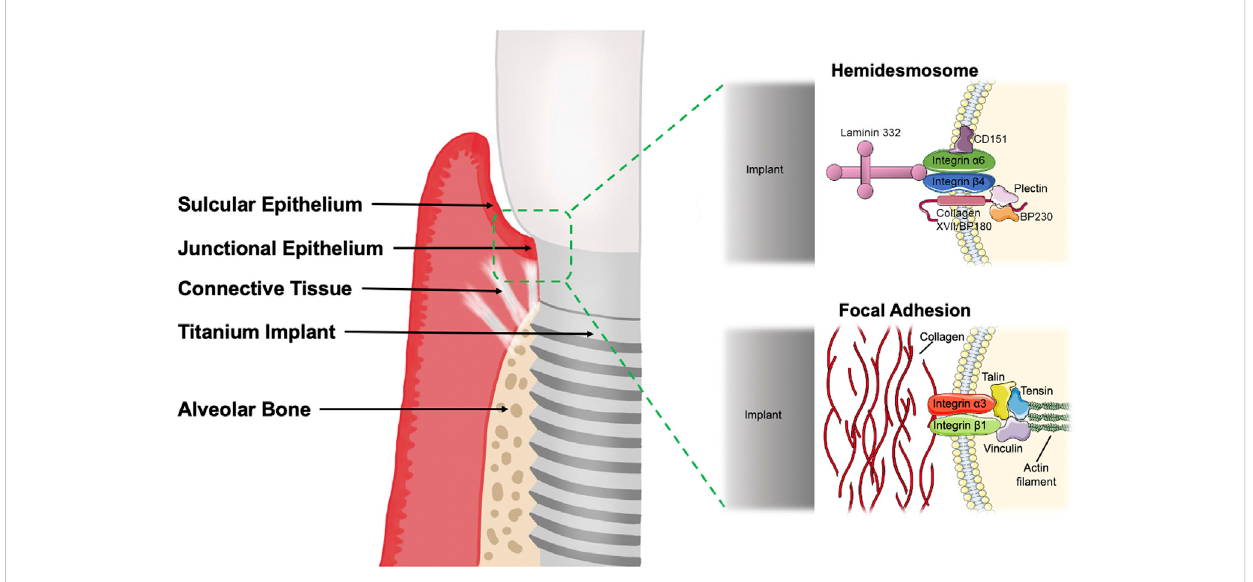
FIGURE 1 The soft tissue seal around the implant consists of gingival junctional epithelium and connective tissue. The peri-implant junctional epithelium adheres to the implant mainly through hemidesmosome structures, while the gingival fi broblasts exert adhesion mainly through focal adhesions. The fi gure was partly generated using Servier Medical Art, provided by Servier, licensed under a Creative Commons Attribution 3.0 unported license. BP180, Bullous pemphigoid antigen 180; BP230, Bullous pemphigoid antigen